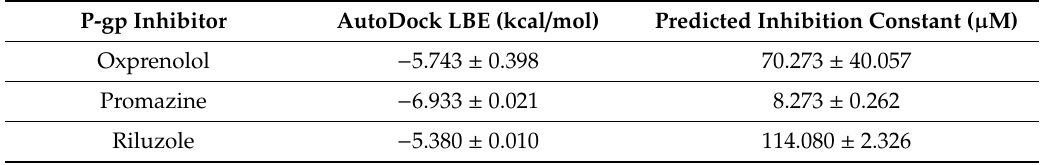
Table 10. Lowest binding energies (LBE) and predicted inhibition constants obtained by molecular docking of the